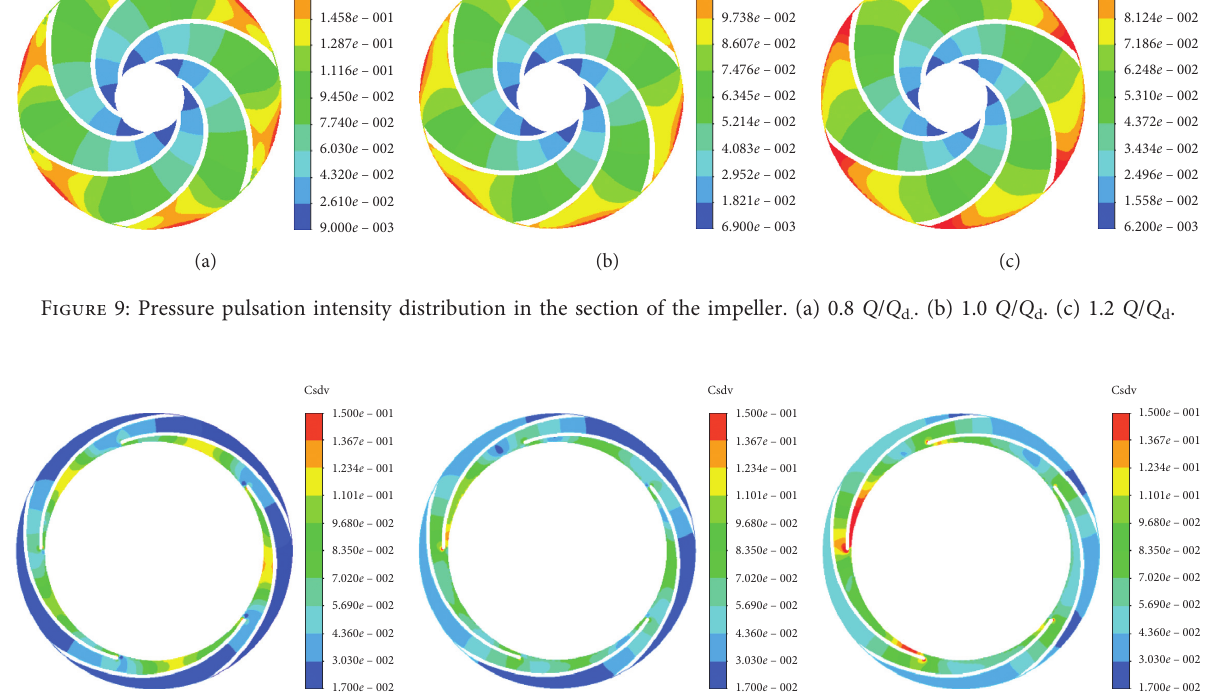
d . (b) 1.0 Q / Q d . (c) 1.2 Q / Q d .